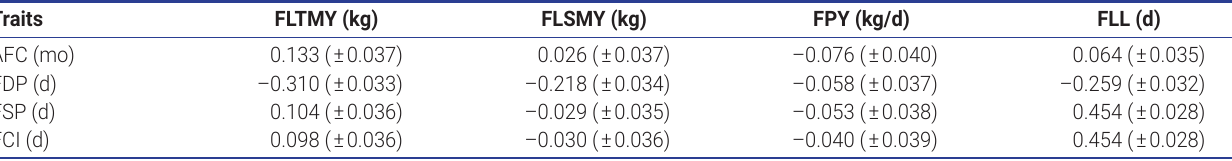
Table 7. Phenotypic correlation between first lactation production and reproduction traits